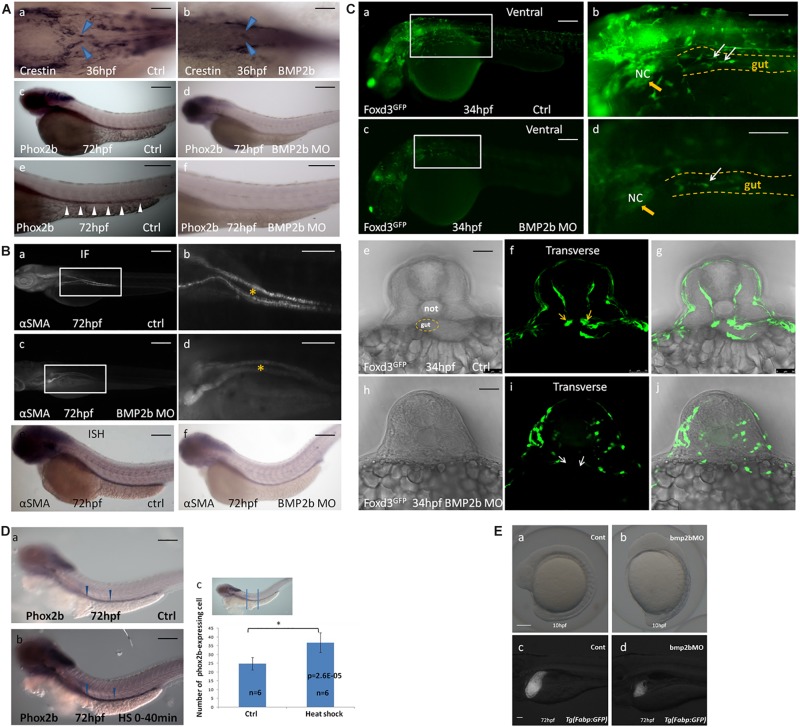
BMP2b is required for normal ENS and intestinal smooth muscle development. (A,a,c,e;B,a,b,e;C,a,b,e,f,g) wild-type embryos, (A,b,d,f;B,c,d,f;C,c,d,h,i,j) BMP2b MO embryos. (A,b) Dorsal viewing for the vagal region of 36 hpf embryos hybridized with crestin probe showed a defective vagal NCC migration to the anterior end of the intestine in BMP2MO morphants(26/37, 70.3%). (A,d,f) Lateral view of 60 hpf embryos hybridized with phox2b probe showing a failure of precursors migration to the anterior of the intestine in BMP2MO morphants(26/34, 76.5%). (B,c,d) Immunofluorescence showed the developmental defect of intestinal smooth muscle in the intestine of BMP2b MO embryos(22/30, 73.3%). (B,f) Lateral view of the intestine for 72 hpf embryos hybridized with α-SMA showing a reduce of α-SMA expressing in the intestine of BMP2b MO embryos(31/39, 79.5%). (C,c,d,h,i,j) Lateral and transverse view the vagal region of 34 hpf embryos labeled with GFP for foxd3 showed a failure of vagal NCC migration in BMP2MO morphants(29/36, 80.5%). (D) BMP2 overexpression results in an increase in enteric neurons. Lateral views of phox2b in enteric ganglia of 72 hpf control (D,a) and HS embryos (D,b). (D,c) Bar graph summarizes the results from one of three independent BMP2 HS experiments (six zebrafish in different groups). The phox2b expressing cells in the HS group is approximately 1.5 fold of ctrl group (n = 6, t-test, ∗P < 0.05, compared with ctrl group). (E) BMP2b is necessary to maintain the anterior-posterior axis of embryos display and liver development. (a) control embryos(114/120, 95%). (b) BMP 2b MO treated embryos that have the anterior–posterior axis of embryos displayed defect(43/60, 71.7%). (c) control embryos(68/80, 85%). (d) BMP2b MO treated embryos, the liver became smaller on day 3(51/76, 67.1%). Bar, 100 μm. Notice: here “26/37” means 26 out of the 37 embryos had defective NCC migration like in the image showed. The following statistical numbers for embryos like this have the same meaning in the Figure legends. Blue arrows (A) indicate the migrating enteric precursors. White arrowheads (A) indicate phox2b expressing cells in the intestine. Asterisk (B) indicate gut. Yellow arrowheads (C) indicate vagal region. White arrows (C) indicate the migrating enteric precursors.